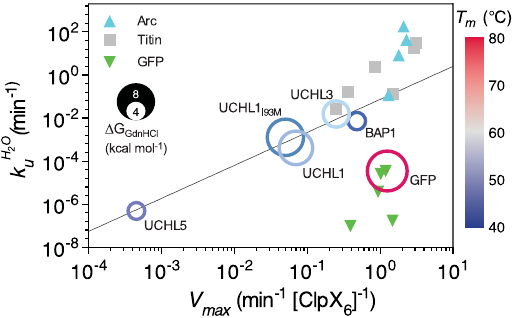
Figure 3. Correlation plots of ClpXP-mediated proteolysis rates, V max , with respect to intrinsic unfolding rate k uH O 2 . The data points of UCHs and GFP are shown in open circles with their radii proportional to the free energy of unfolding Δ G GdnHCl as indicated on the left. Since UCHL1 variants exhibited a three-state equilibrium (Table S1), their radii correspond to the sum of Δ G N-I and Δ G I-D . Furthermore, the data points are color- ramped from blue to grey to red according to their melting temperatures, T m , as indicated on the right. The linear regression of the double-log plot of UCHs data points yields a slope of 1.48 ± 0.18 and a log( k uH O 2 ) intercept of − 3.10 ± 0.31 when log(V max ) = 0 (R 2 = 0.96), shown in solid black line. The previously reported data of Arc (cyan triangles), titin I27 (Titin; grey squares) and GFP (inverted green triangles) are shown for comparison (Table